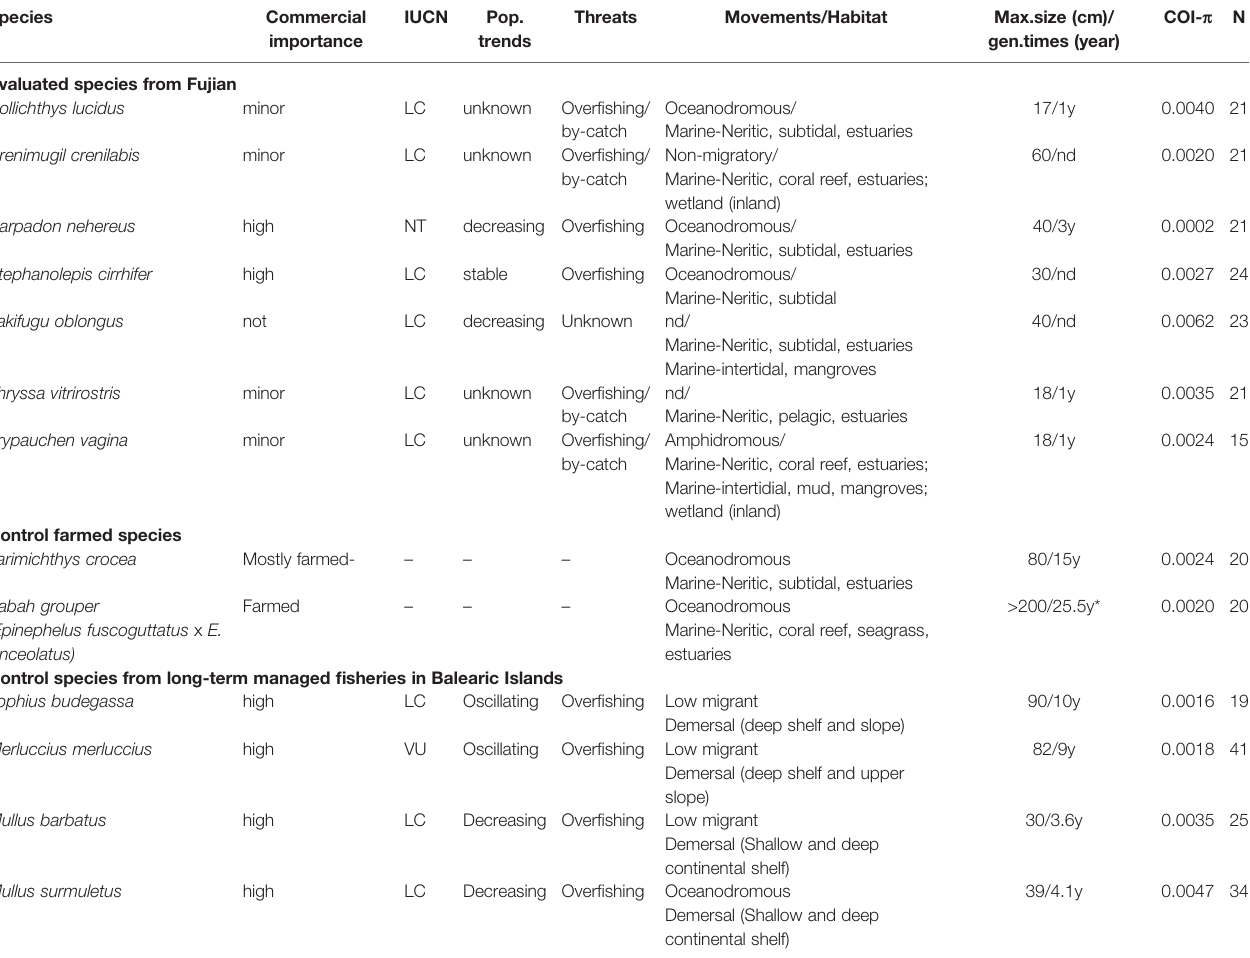
TABLE 1 | Sampled fi sh species, their characteristics and genetic diversity estimates in COI mitochondrial gene (COI- p